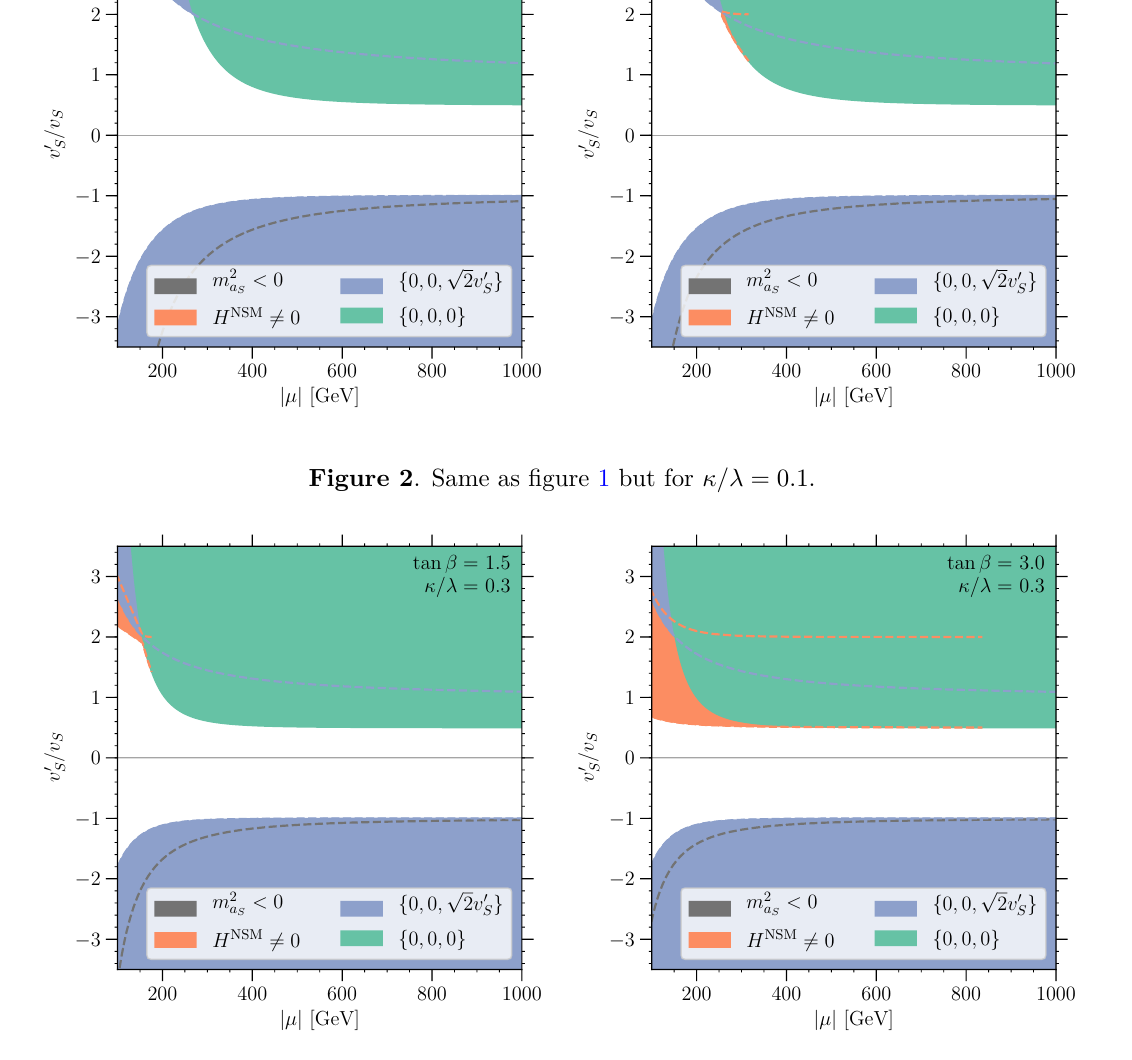
Figure 3 . Same as figure 1 but for κ/λ = 0 . 3